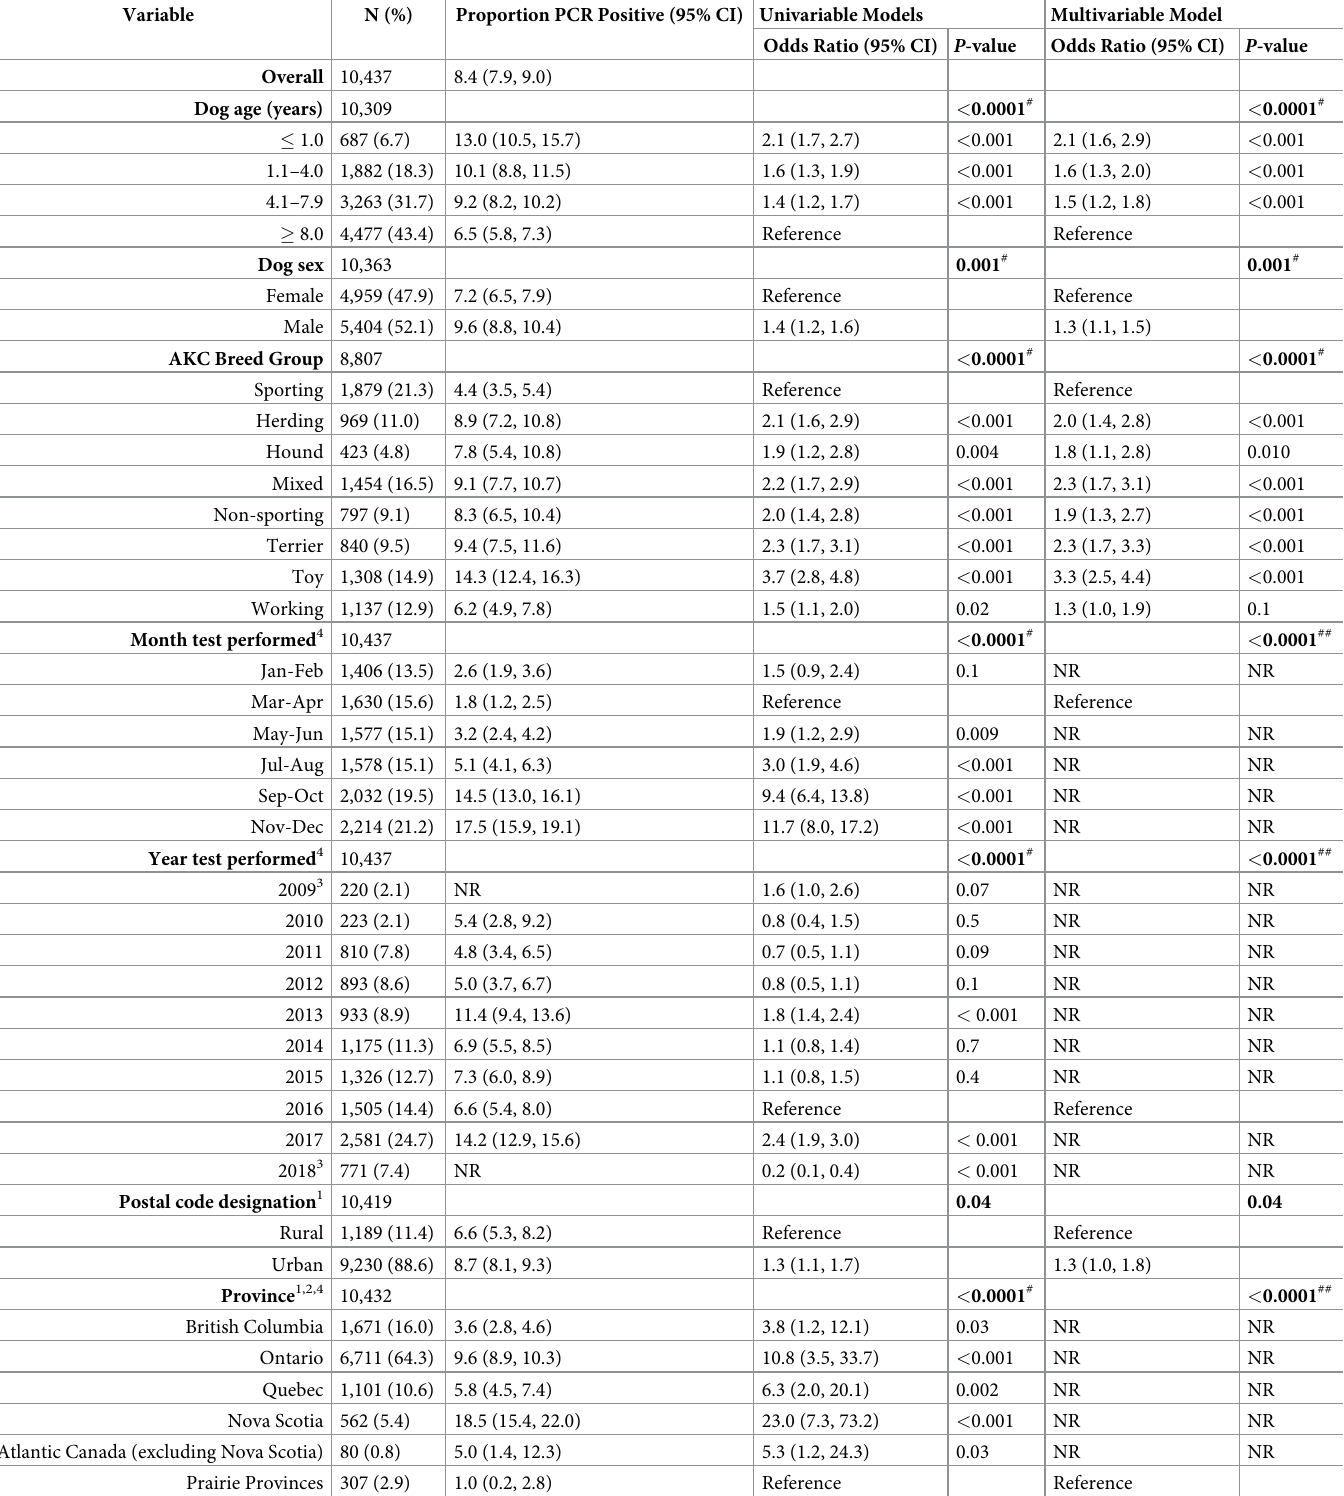
Table 1. Proportion PCR-test positive and univariable and multivariable logistic regression models for canine Leptospira PCR tests in Canada (2009–2018).